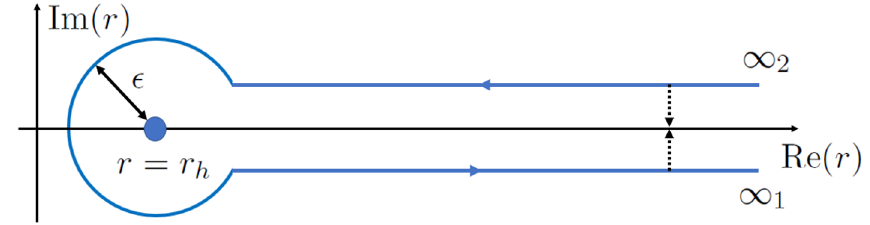
Figure 1 . The holographic prescription for the Schwinger-Keldysh closed time path [40]: complex- ified radial coordinate and analytical continuation around the horizon r